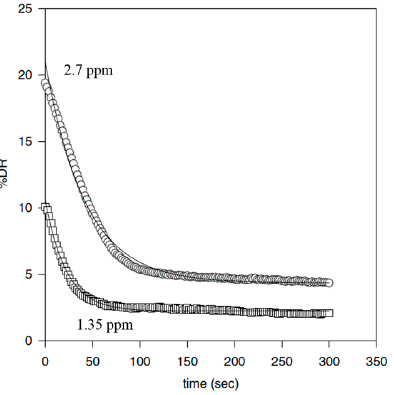
Figure 7. Drag reduction versus time with λ -DNA at different concentrations, reprinted with permission from [79]. Copyright American Physical Society, 2002.